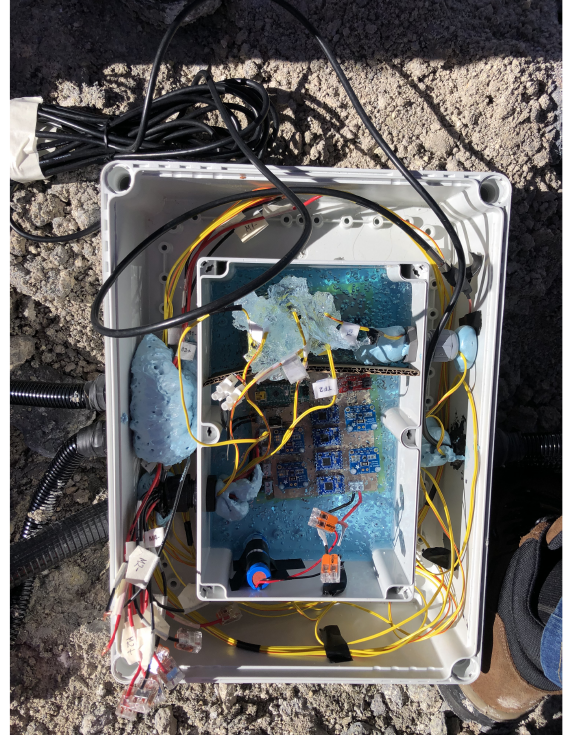
Figure 8. Detail of the protection boxes to avoid corrosion in the